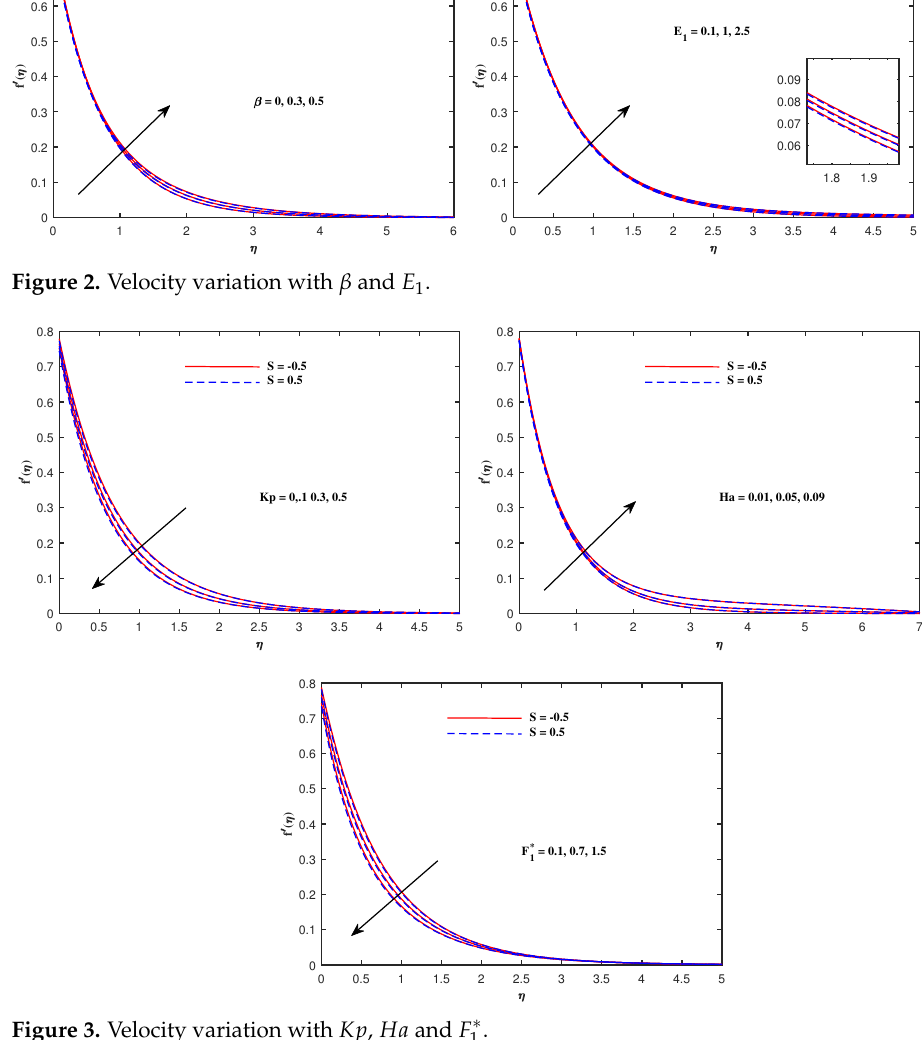
Figure 3. Velocity variation with Kp , Ha and F ∗ . 1 From Figure 6, it is depicted that the temperature increases when Nb and Nt increase. The faster Brownian movement and thermophorsis strengthen the thermal